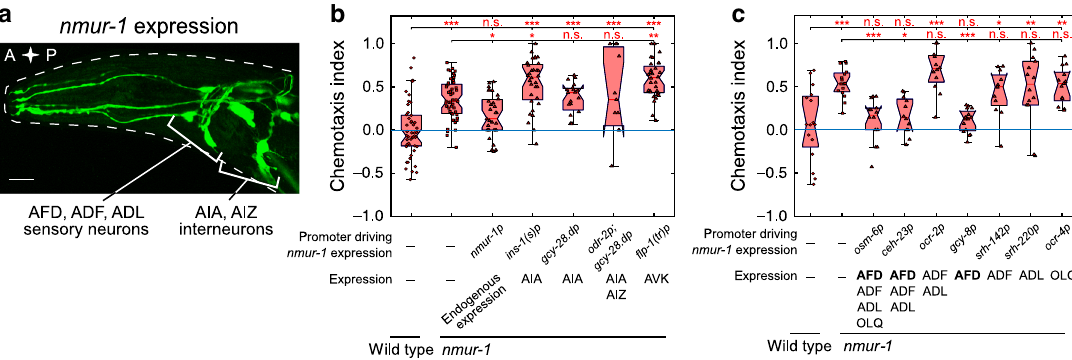
Fig. 2 nmur-1 is required in AFD sensory neurons for gustatory aversive learning. a Transgenic adult hermaphrodite C. elegans expressing a bicistronic GFP construct including the promoter, cDNA and 3 ′ UTR of the nmur-1 gene ( nmur-1p::nmur-1::SL2::gfp ). Scale bar, 35 µ m. b , c Chemotaxis index of NaCl- conditioned nmur-1 (ok1387) animals in which nmur-1 expression is restored under the control of its b endogenous promoter or in selected interneurons and c in sensory neurons. Signi fi cances determined by one-way ANOVA and Tukey ’ s post hoc test. n.s. not signi fi cant; * p ≤ 0.05; ** p ≤ 0.01; *** p ≤ 0.001. b From left to right n = 50, 50, 31, 32, 19, 12, 32 experimental repeats. c From left to right n = 16, 16, 12, 14, 12, 13, 12, 14, 16 experimental repeats. Boxplots show medians, 25th and 75th percentiles as box limits. The whiskers extend to the most extreme data points not considered as outlier.